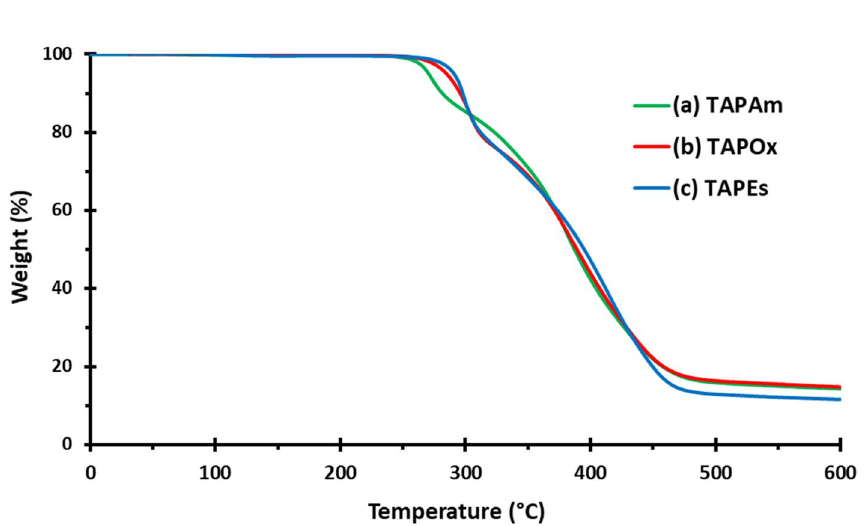
Figure 13. TGA thermogram of ( a ) TAPAm, ( b ) TAPOx and ( c ) TAPEs recorded at a heating rate of 10 °C/min in nitrogen